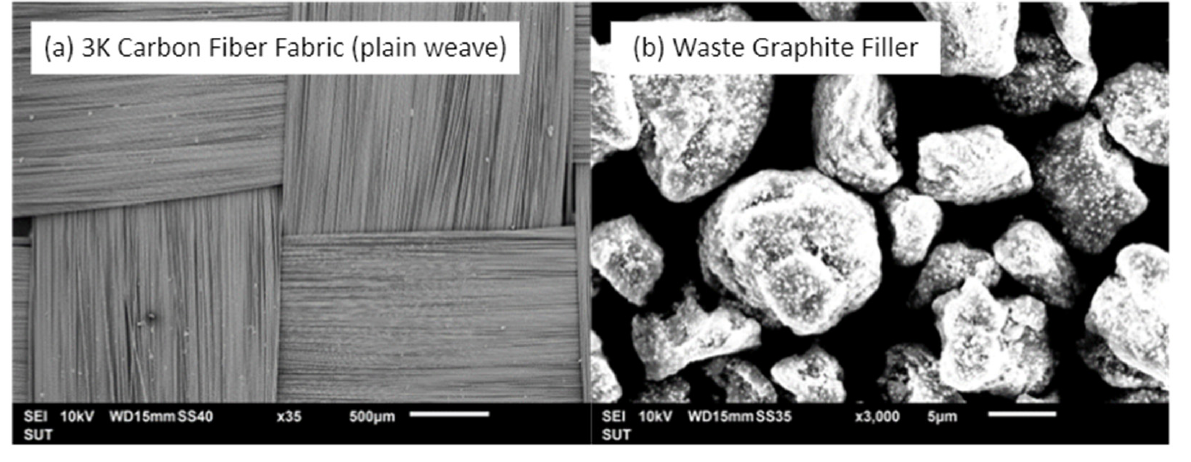
Figure 1. SEM photograph of the expanded view: ( a ) 3K carbon fiber fabric-plain weave, and ( b ) waste graphite filler.